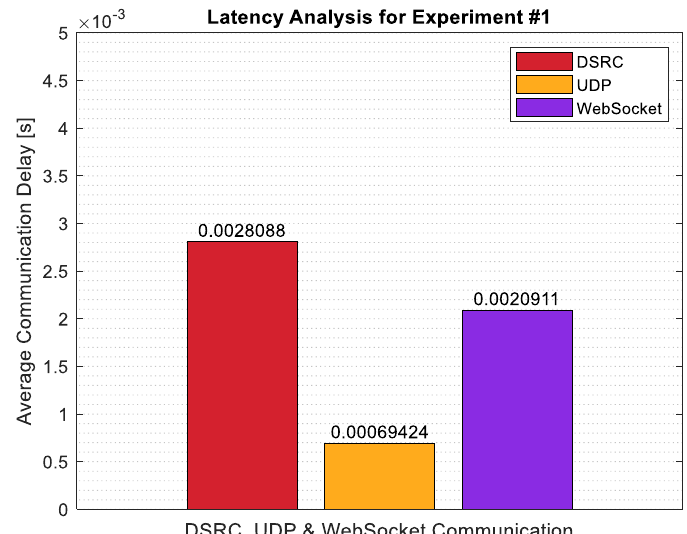
Figure 9. Latency analysis for Experiment #1.